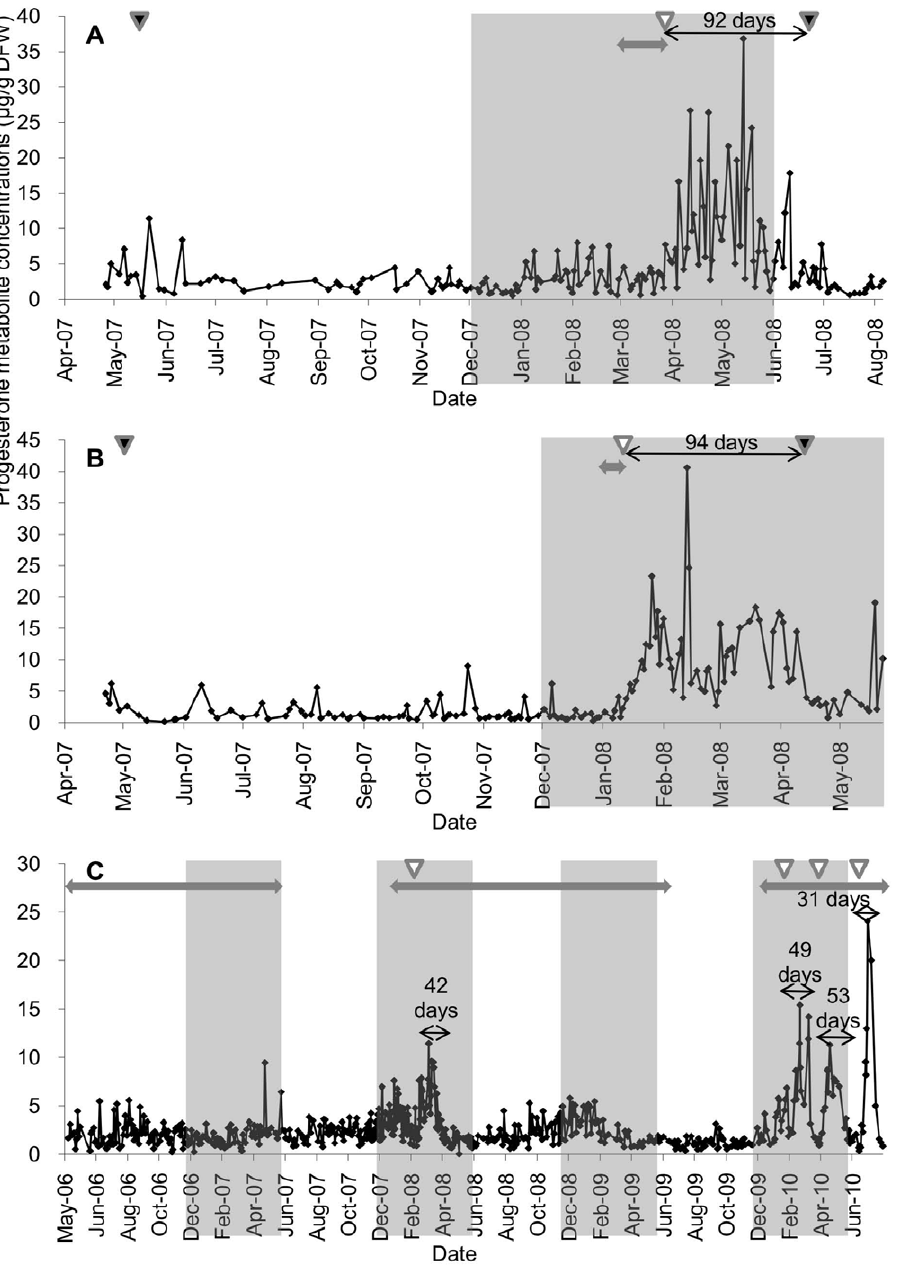
Figure 2. Daily fecal progesterone metabolite concentrations in three female snow leopards (A: female A, B: female B, C: female C). The shaded areas, two-headed arrows and white arrowheads are explained in Fig.1. The black arrowheads designate the day of parturition. The thin two-headed arrows and the number of days represent the pregnancy or pseudopregnancy duration.